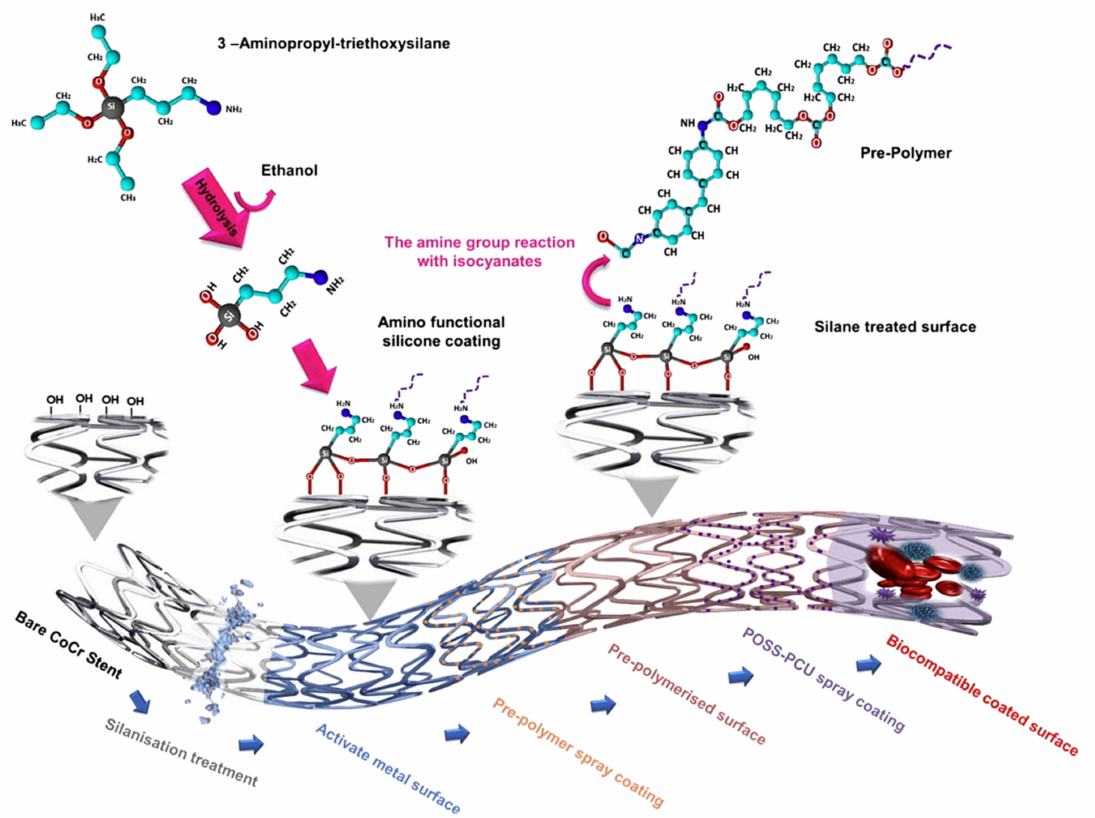
Figure 8. BMS stent pre-treatment and POSS-PCU spray coating procedure to obtain a biocompatible coated surface. Reprinted with permission from Farhatnia, Y.; Pang, J.H.; Darbyshire, A.; Dee, R.;